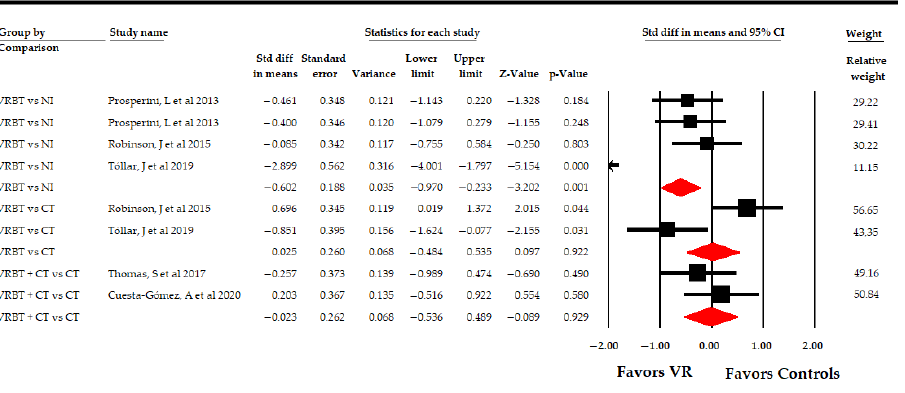
Figure 5. Subgroup Analysis of the Effect of Virtual Reality on the Impact of Multiple Sclerosis According to Specific Comparisons.